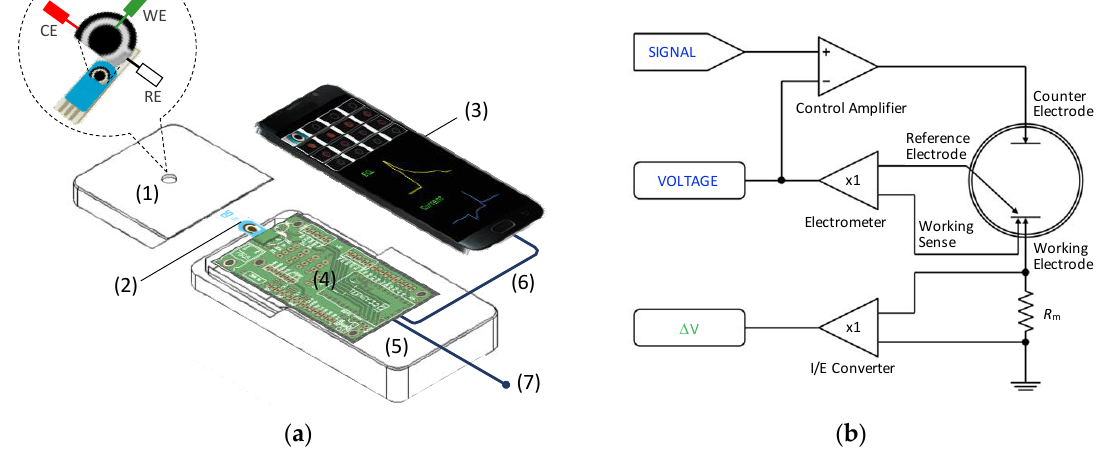
Figure 2. Schematic diagram of ( a ) the mobile phone-based electrochemiluminescence (ECL) sensor apparatus that mainly comprises (1) a magnifying lens, (2) screen-printed electrodes, (3) a smartphone, (4) a potentiostat circuit, (5) a light-tight container, (6) a Universal Serial Bus (USB) cable, and (7) a cable to the battery or USB port; ( b ) the basic operation of the portable potentiostat